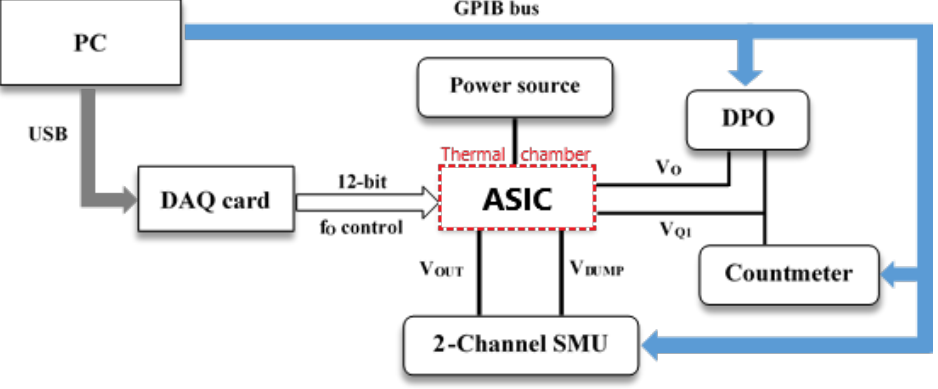
Figure 7. Experimental setup block diagram.